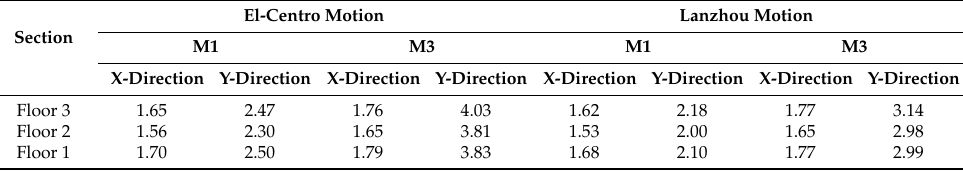
Figure 16 . Relative displacement curves of the top floor. Figure 16. Relative displacement curves of the top floor. Table 4. Layer drifts (mm). Table 4. Layer drifts